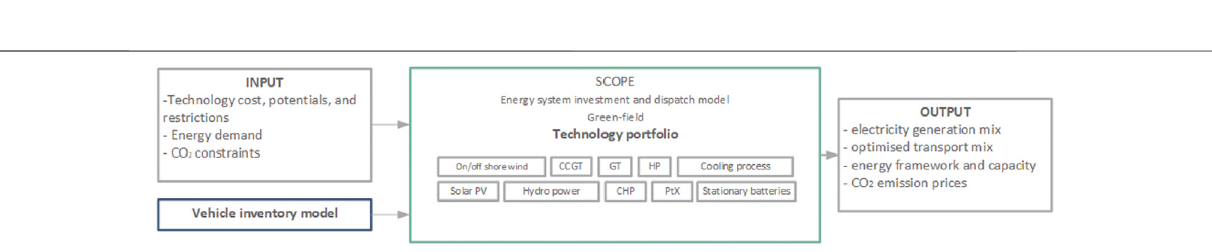
FIGURE 1 | Overview of the ELIN-EPOD model package indicating the input and output data and the technologies in which investment can be made. CCGT, Combined cycle gas turbine; GT, gas turbine; CHP, combined heat and power; EV, electric vehicle, PV, photovoltaic.